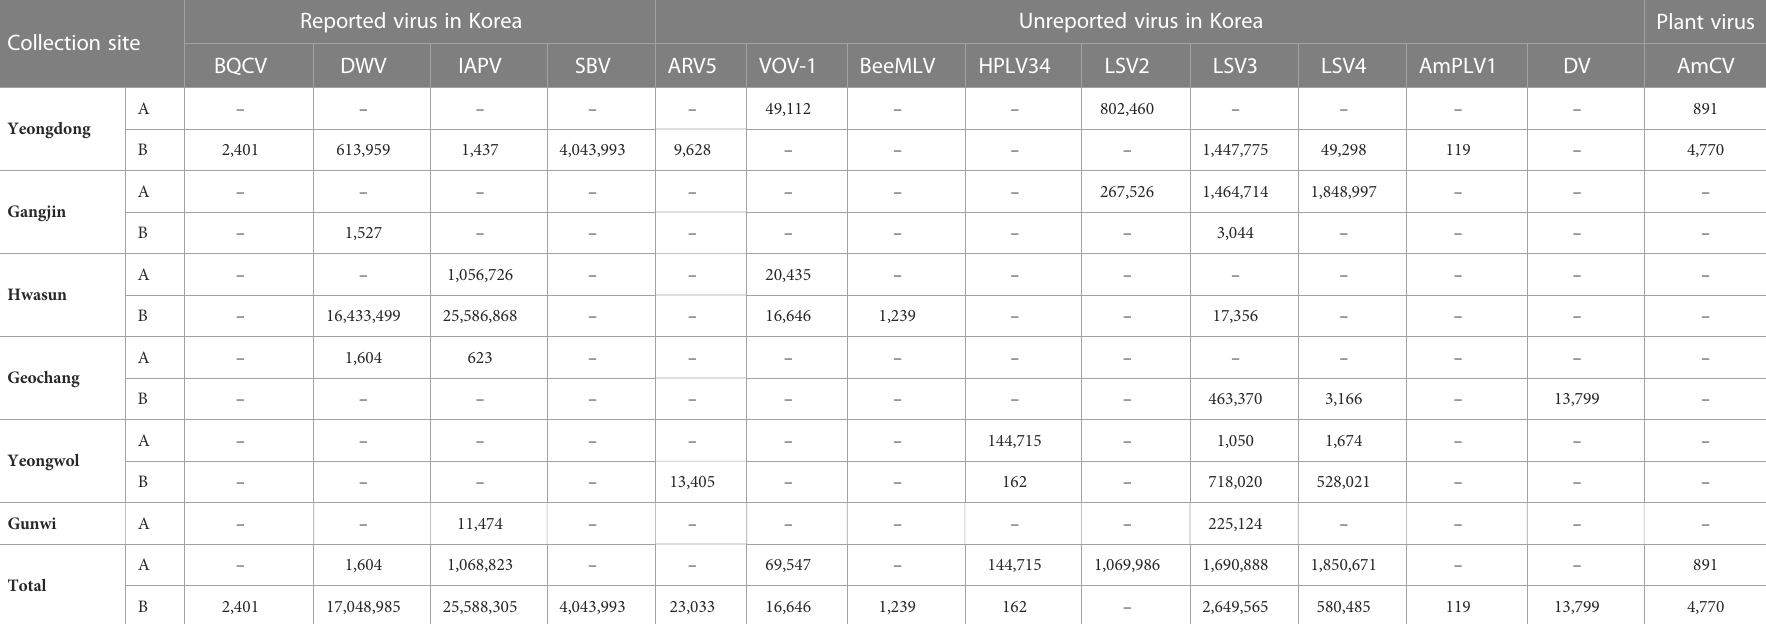
TABLE 2 Numbers of mapped reads matched with viral genomes.